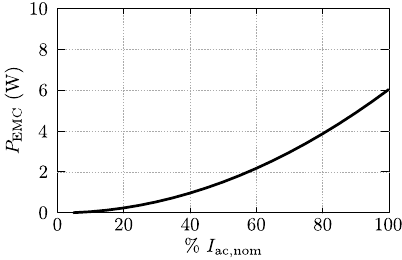
Figure B5. Calculated total losses of the EMC input